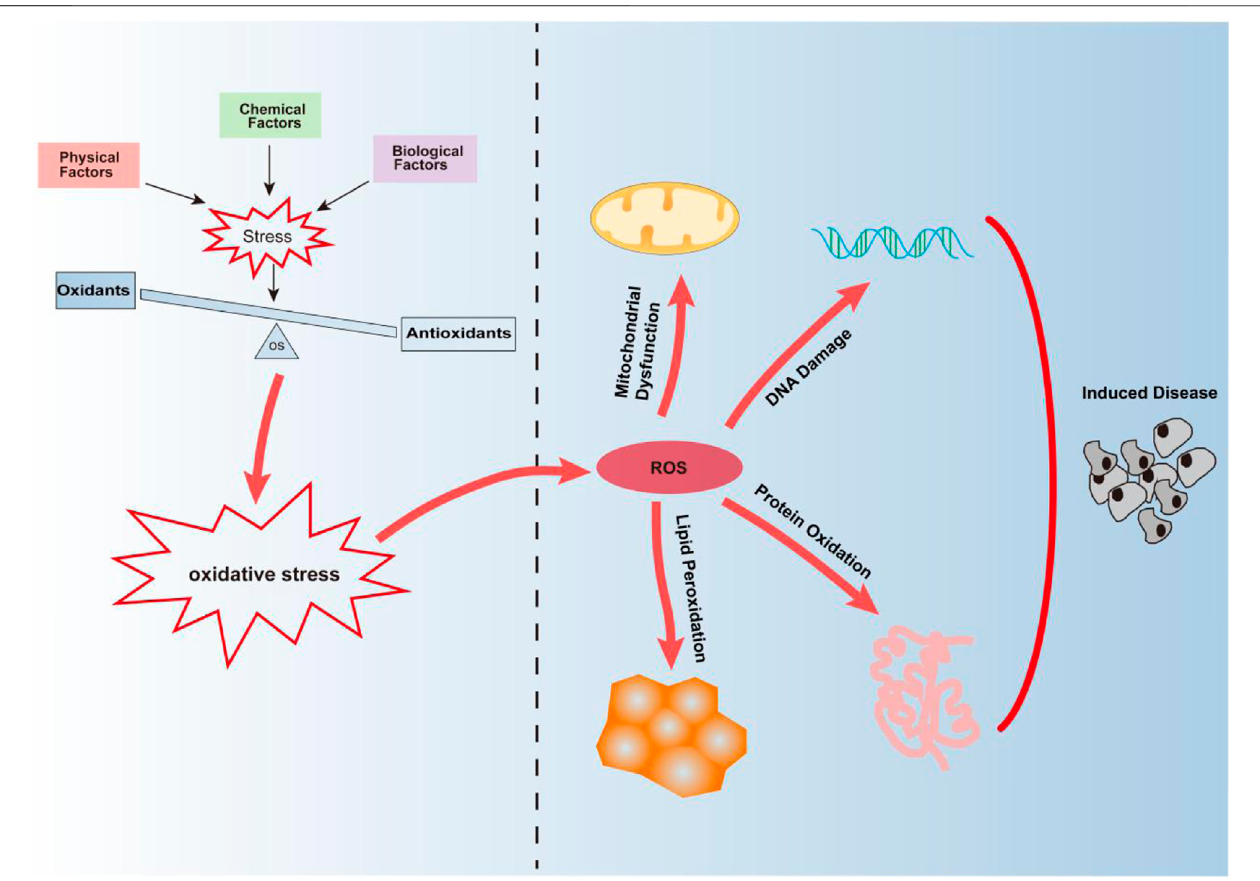
FIGURE 1 | Oxidative stress is mainly caused by the imbalance between oxidation and antioxidant defense mechanisms caused by physical, chemical, and biological factors. Continuous oxidative stress can lead to the accumulation of ROS leading to mitochondrial dysfunction, DNA damage, protein oxidation, and lipid peroxidation, thus inducing the occurrence of